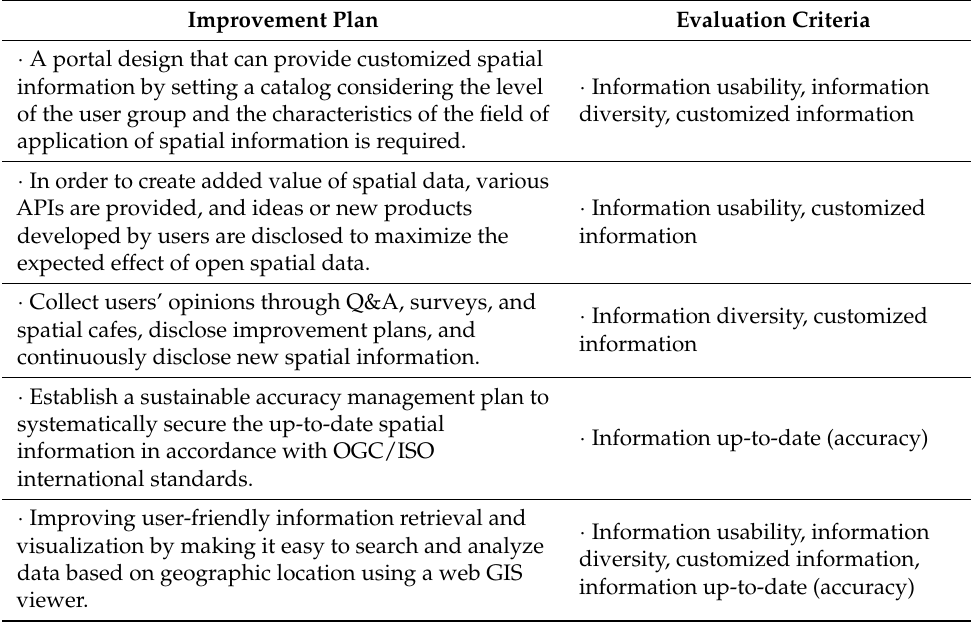
Table 6. Improvement plan for information